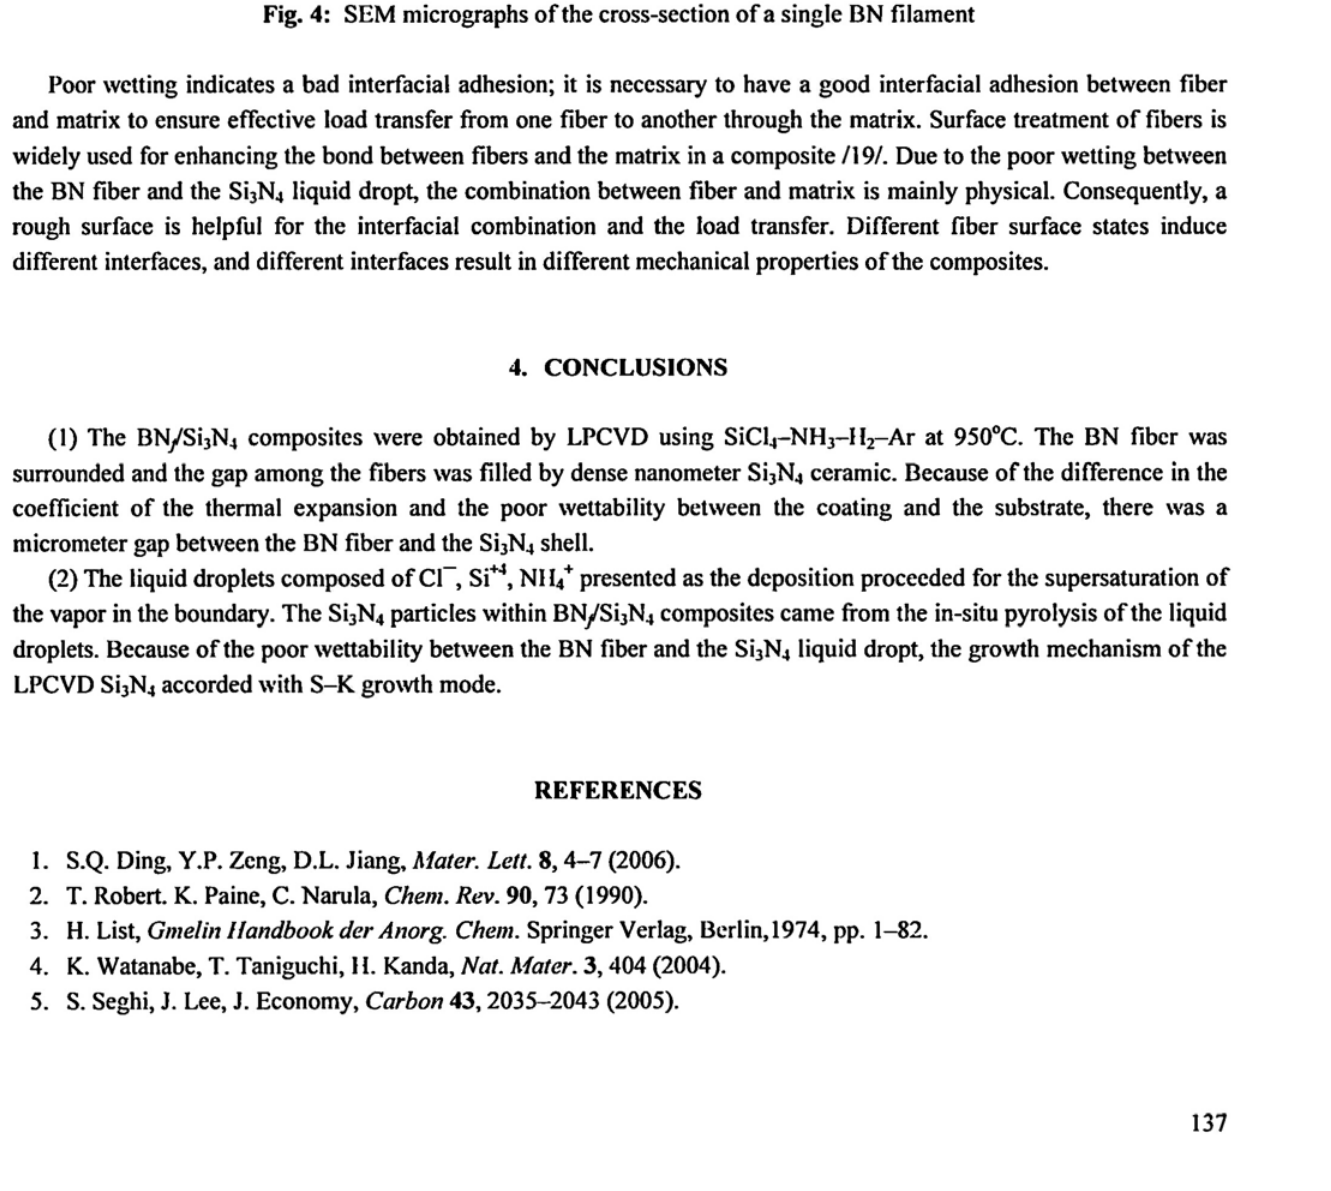
Fig. 4: SEM micrographs of the cross-section of a single BN